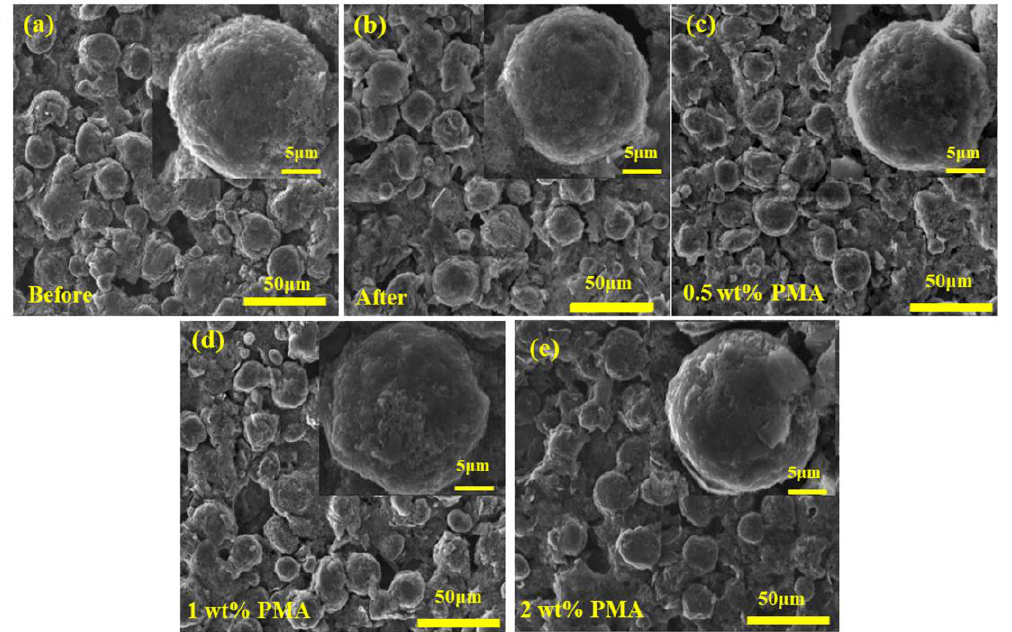
Figure 5 . FE-SEM image of MCMB ( a ) before or after 3 cycles with ( b ) free additive, ( c ) 0.5 wt.%, ( d ) 1.0 wt.% and ( e ) 2.0 wt.% of PMA electrolyte additives.